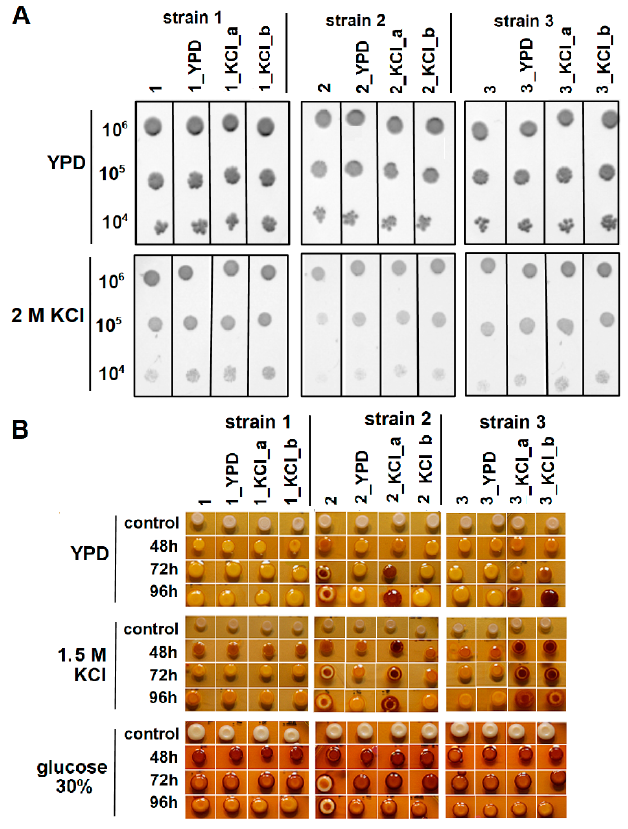
Figure 2. ( A ) Analysis of the effect of KCl-induced osmotic stress on the growth phenotype of the analyzed strains by spot test assays. Yeast cells were grown on solid YPD medium (control) or on YPD medium supplemented with 2 M KCl (osmotic stress conditions). Representative photographs are shown. ( B ) Iodine-staining of glycogen stores (indicated by reddish-brown coloration) of yeast colonies. Ancestral and evolved derivatives of strains 1, 2, and 3 were grown for 48, 72, and 96 h in standard solid YPD medium, YPD medium supplemented with 1.5 M KCl, or YPGlu containing 30% glucose. The staining reactions of the colonies were recorded for 1 min after adding the iodine solution. Control-yeast colonies not treated with iodine solution. 1, 2, and 3–ancestral strains 1, 2, and 3, respectively; 1_YPD, 2_YPD, 3_YPD – YPD-evolved derivatives of strains 1, 2, and 3 (control), respectively; 1_KCl_a, 2_KCl_a, and 3_KCl_a–1.25 M KCl-evolved derivatives of strains 1, 2, and 3,